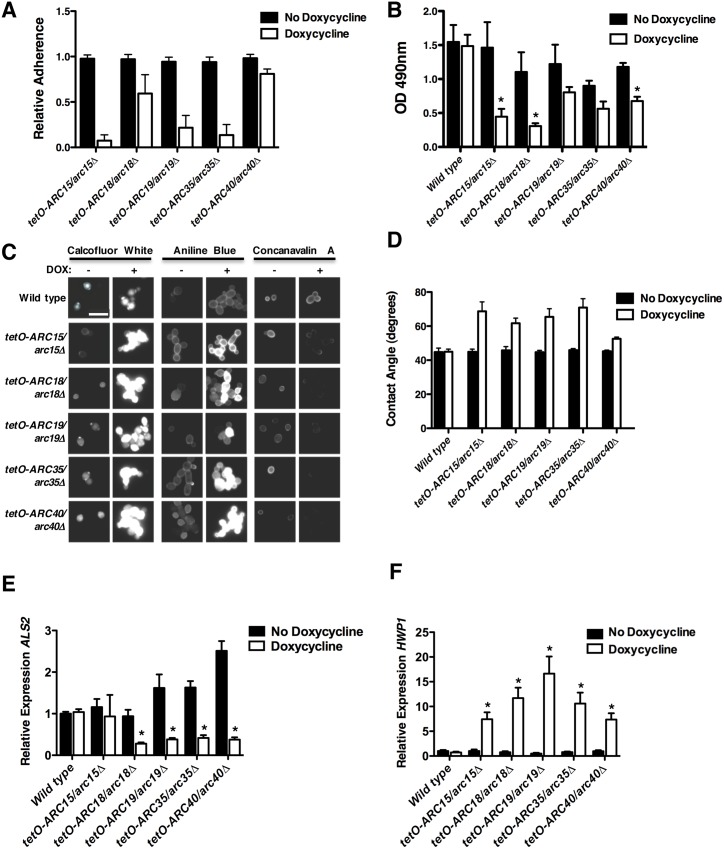
The Arp2/3 complex plays a critical role in adherence, biofilm formation and cell wall physiology.(A) Non-barcoded conditional expression strains for Arp2/3 complex components were grown overnight in the absence or presence of doxycycline. Adherence was measured as described in Fig 1C. Error bars represent standard deviations of five technical replicates. Transcriptional repression of all target genes significantly impaired adherence (P<0.001, ANOVA, Bonferroni's Multiple Comparison Test). (B) Transcriptional repression of Arp2/3 complex components reduces biofilm formation. Biofilms were grown and metabolic activity was measured as described in Fig 2a. Error bars represent standard deviations of three technical replicates. Asterisks indicate significantly altered biofilm formation upon transcriptional repression of target genes (P<0.05, ANOVA, Bonferroni's Multiple Comparison Test). (C) Transcriptional repression of Arp2/3 complex components alters cell wall physiology. Staining and visualization of cells was performed as described in Fig 3A. Scale bar represents 10 μm. (D) Transcriptional repression of Arp2/3 complex components alters cell surface hydrophobicity. Experiment was performed and analyzed as described in Fig 3B. Error bars represent standard deviations of nine technical measurements. Transcriptional repression of Arp2/3 components significantly alters cell surface hydrophobicity (P<0.001, ANOVA, Bonferroni's Multiple Comparison Test). (E)
ALS2 or (F)
HWP1 transcript levels were monitored after strains were sub-cultured overnight in the absence and presence of doxycycline, followed by a sub-culture and growth to log-phase in the absence and presence of doxycycline. The expression of ALS2 and HWP1 was normalized to a GPD1 control, and is plotted relative to the wild-type strain in the absence of doxycycline. Error bars represent standard deviation of technical triplicates. * indicates significant differences between untreated and doxycycline treated conditions (P<0.01, ANOVA, Bonferroni's Multiple Comparison Test). Experiment was performed in duplicate with a representative image shown.